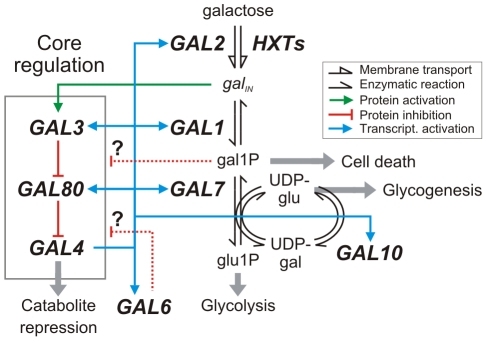
Canonical yeast galactose utilization pathway (adapted from[26]).Gray arrows indicate cellular processes likely impacted by GAL gene deletions. Abbreviations: intracellular galactose (galIN), galactose-1-phosphate (gal1P), glucose-1-phosphate (glu1P), uridine diphosphate (UDP), UDP-glucose (UDPglu), UDP-galactose (UDPgal).